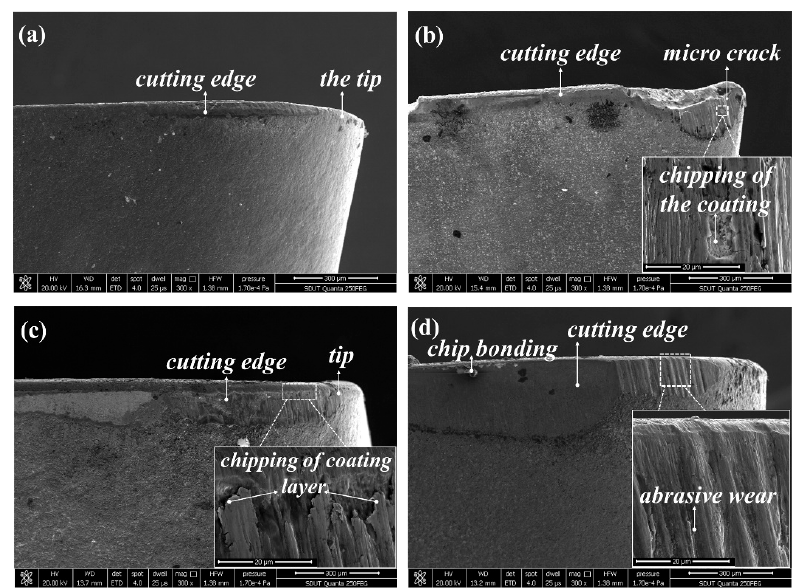
Figure 9. SEM micrograph of tool wear at v c = 280 m/min, f z = 0.02 mm, a p = 0.2 mm, and a e = 2 mm, ( a ) TiN/TiCN/TiAlN multi-coated tool, ( b ) AlTiN coated tool, ( c ) TiAlN + TiN coated tool, and ( d ) TiCN + NbC coated tool.